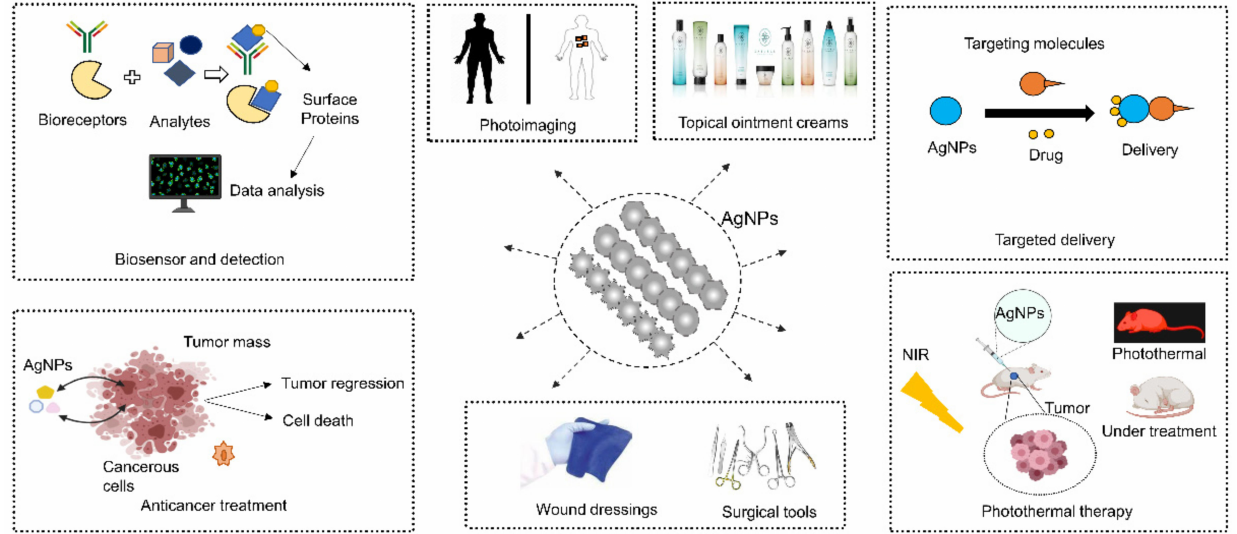
Figure 2. Various biomedical applications of green synthesized